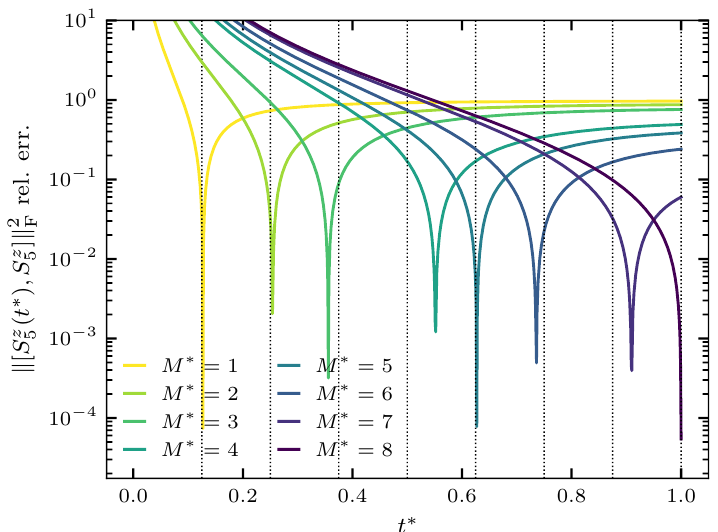
( t ∗ ) between that of a subset M ∗ of Figure 16: The relative error of the OTOC C i = 5, j = 5 layers and that of the target unitary at time t ∗ , for the Heisenberg chain at L = 8 and a depth M = 8 circuit optimized at time t = 1. The curve with M ∗ = M corresponds to the full circuit and the dashed lines mark times tM ∗ /